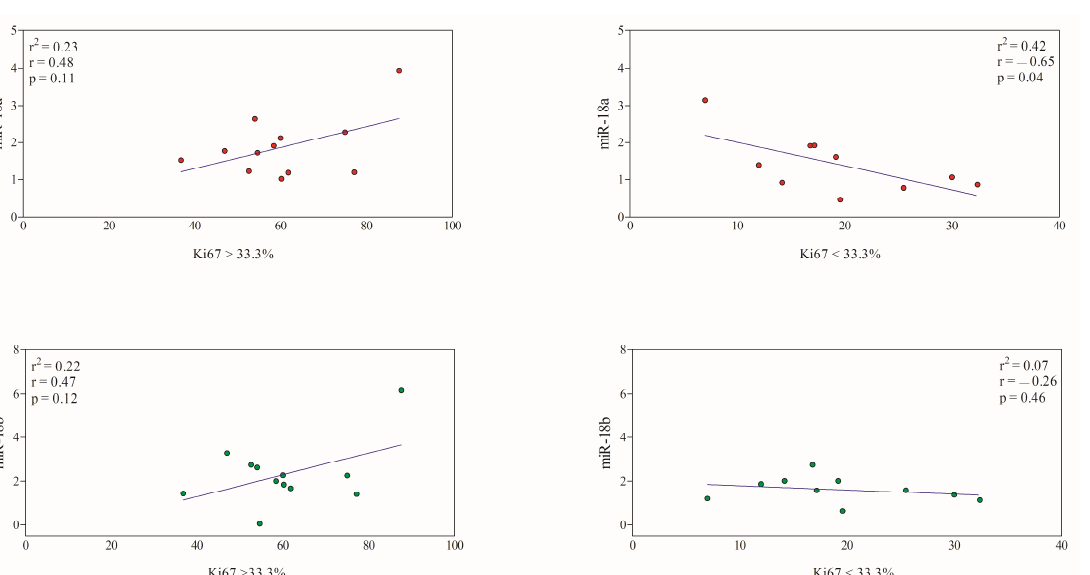
results of the linear regression